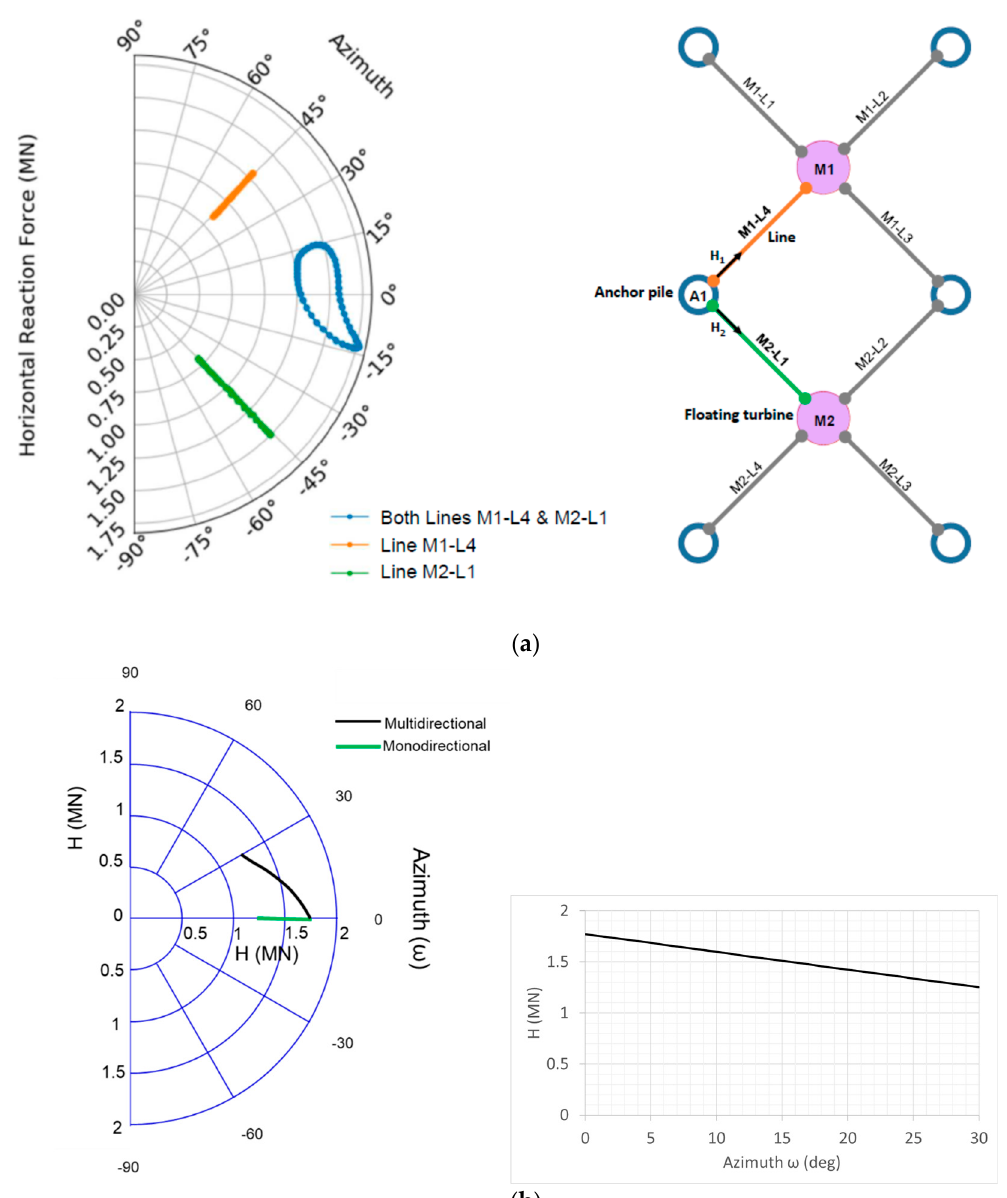
Figure 3. Multidirectional horizontal loading path applied on a pile head. ( a ) Relevant loading case applied on pile anchor A1 by 2 anchor lines M2-L1 and M1-L4, adapted from [23]. ( b ) Reference case of the loading path for the current numerical study.